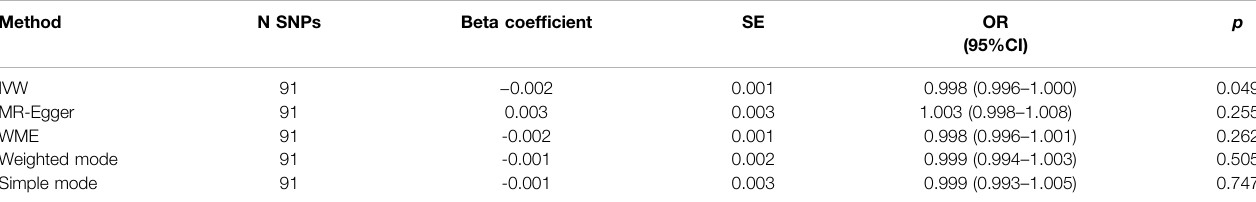
TABLE 1 | Two-sample Mendelian Randomization for tea consumption on obesity risk. Method